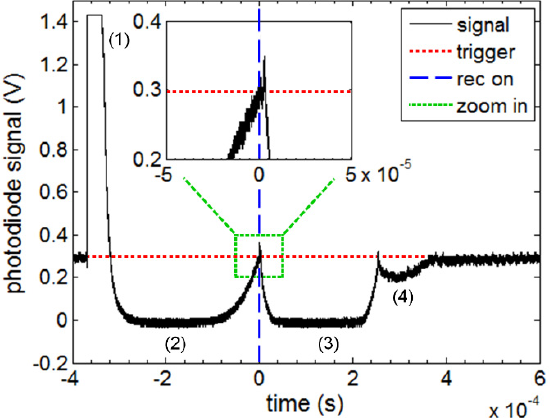
Figure 2. (Black solid line) Photodiode signal for the collapsing bubble, (red dotted line) trigger level for the beginning of high − speed video, (blue dash line) video start (t = 0), (green boxed) zoom in the t = 0 region. ( 1 ) Intensity peak due to the flash of the laser generating the bubble, ( 2 ) first bubble, ( 3 ) rebound bubble, and ( 4 ) second rebound bubble.